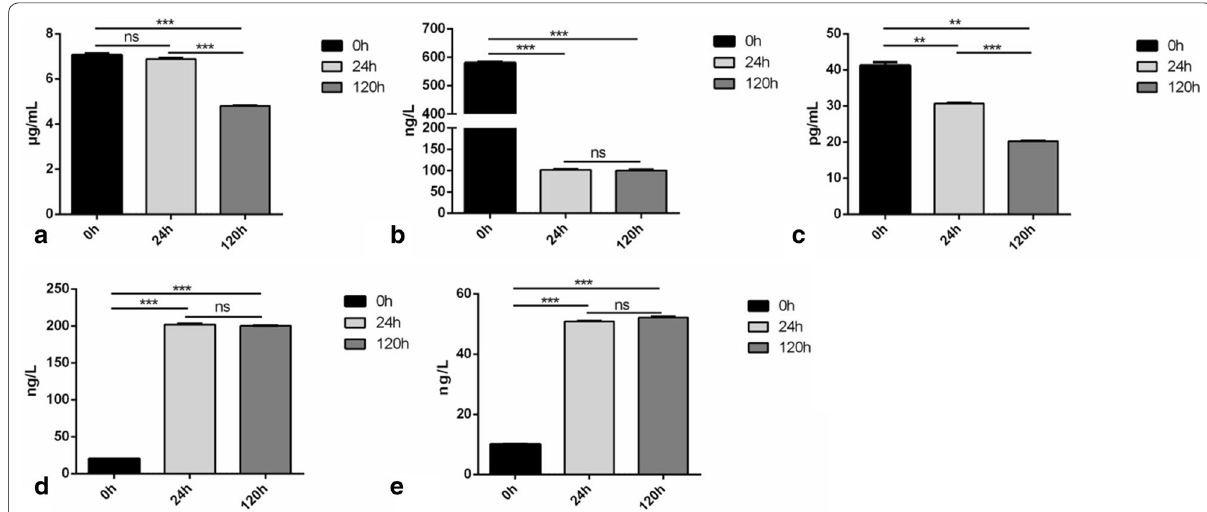
Fig. 7 Validation of DEPs by